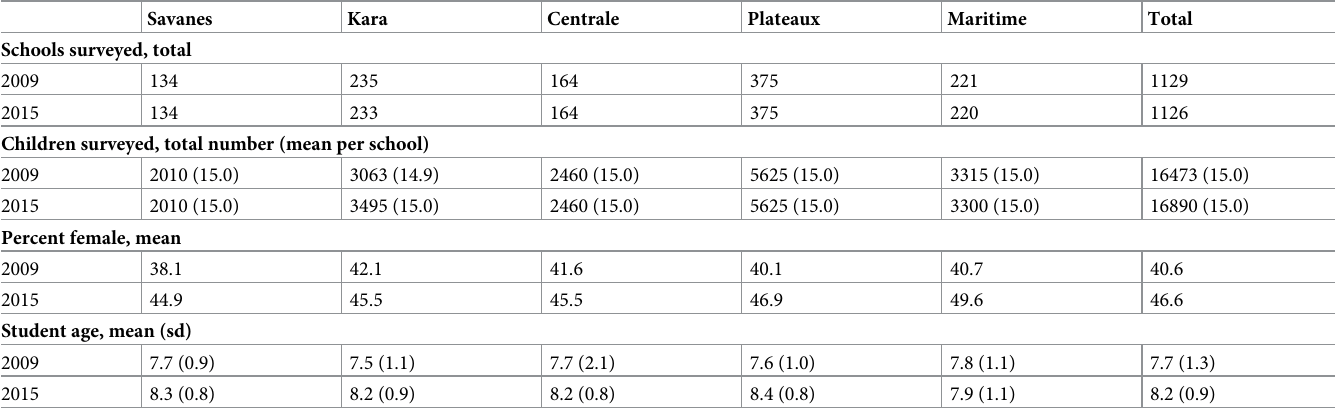
Table 1. Study population by